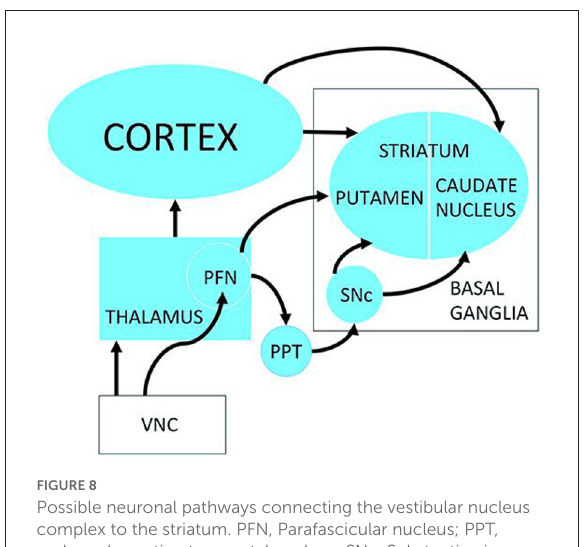
FIGURE8 Possible neuronal pathways connecting the vestibular nucleus complex to the striatum. PFN, Parafascicular nucleus; PPT, pedunculopontine tegmental nucleus; SNc, Substantia nigra pars compacta; VNC, vestibular nucleus complex. Reproduced from Smith